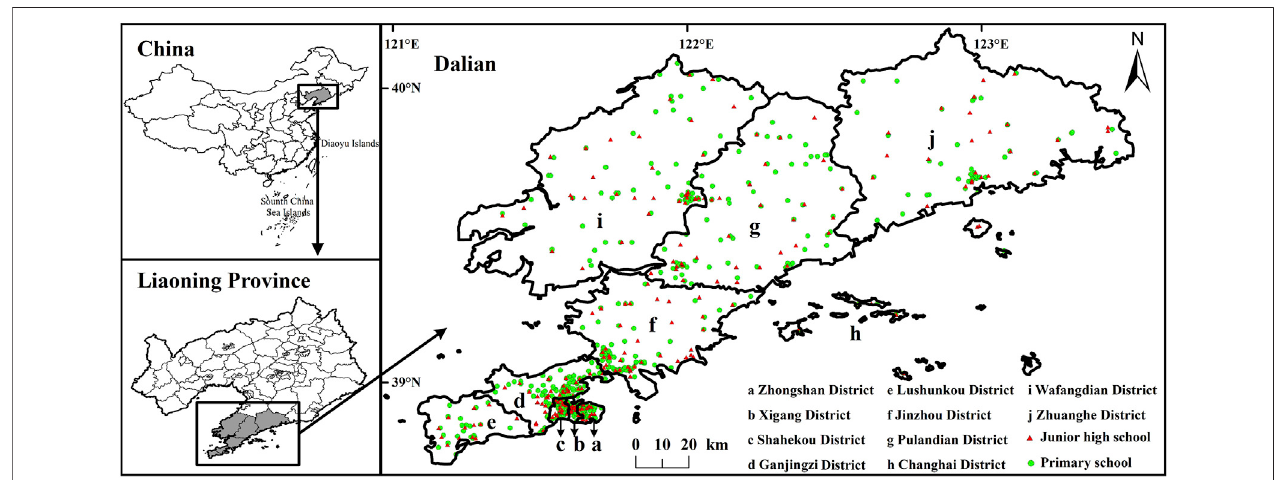
FIGURE 1 | Migrant children distribution in Dalian schools.